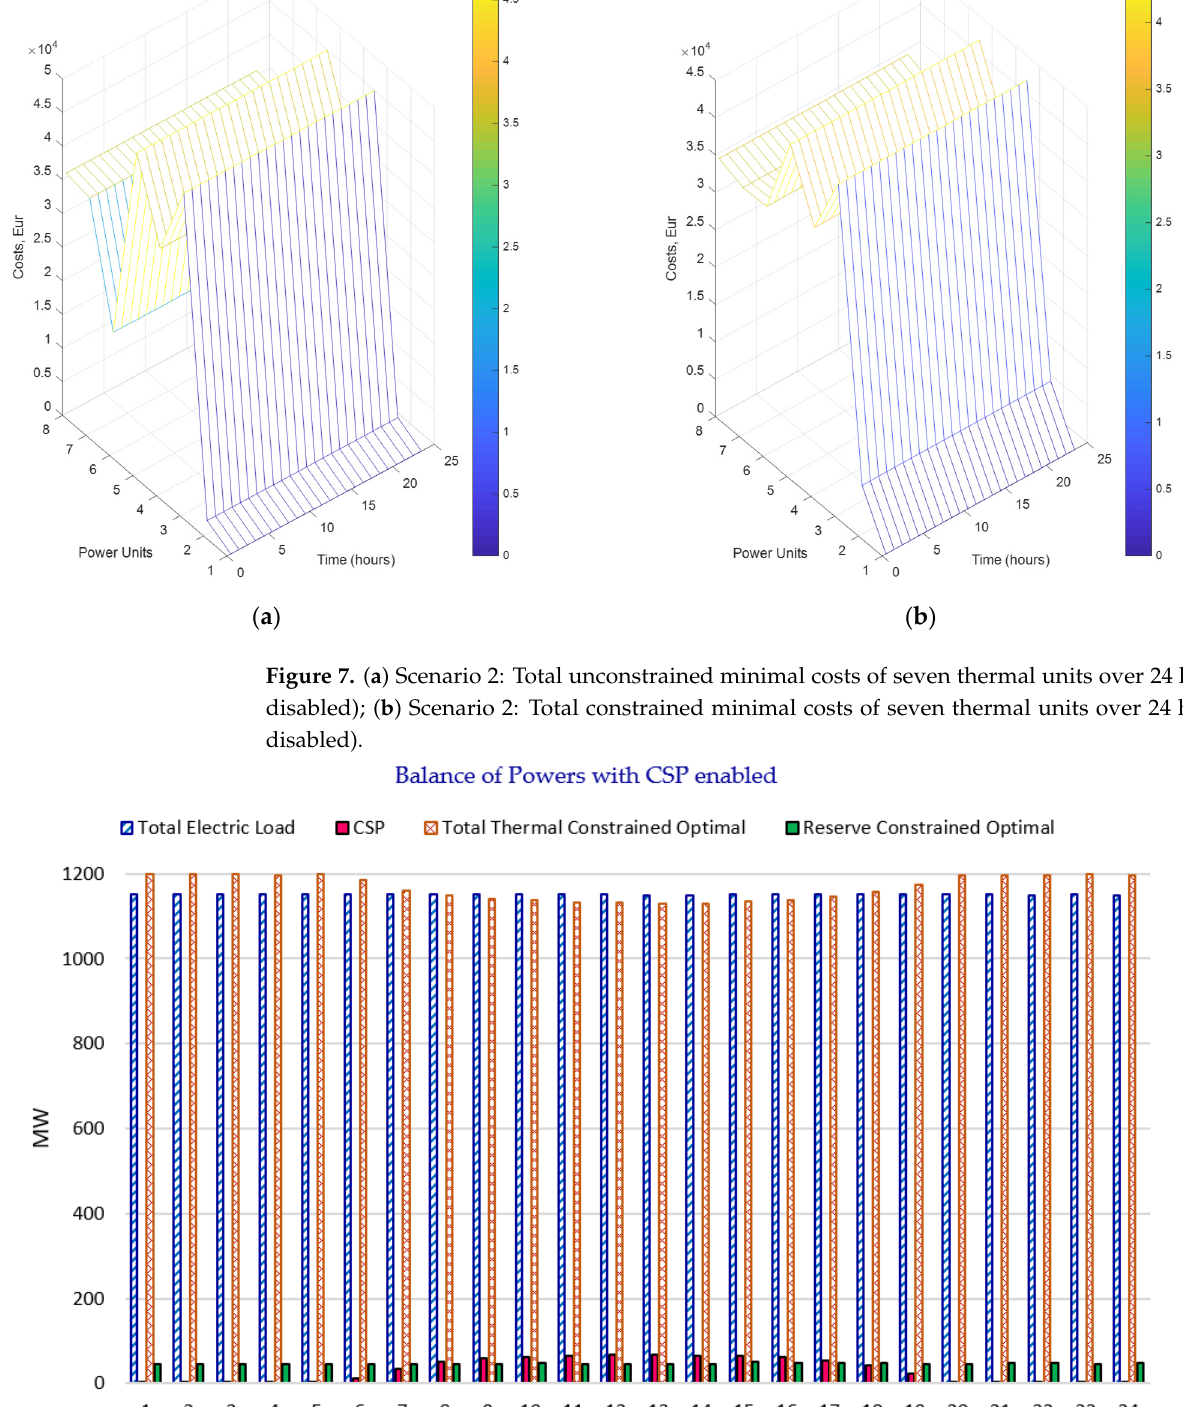
Figure 6. ( a ) Scenario 1: Total unconstrained minimal costs of seven thermal units and CSP over 24 h (CSP enabled); ( b ) Scenario 1: Total constrained minimal costs of seven thermal units and CSP over 24 h (CSP enabled).